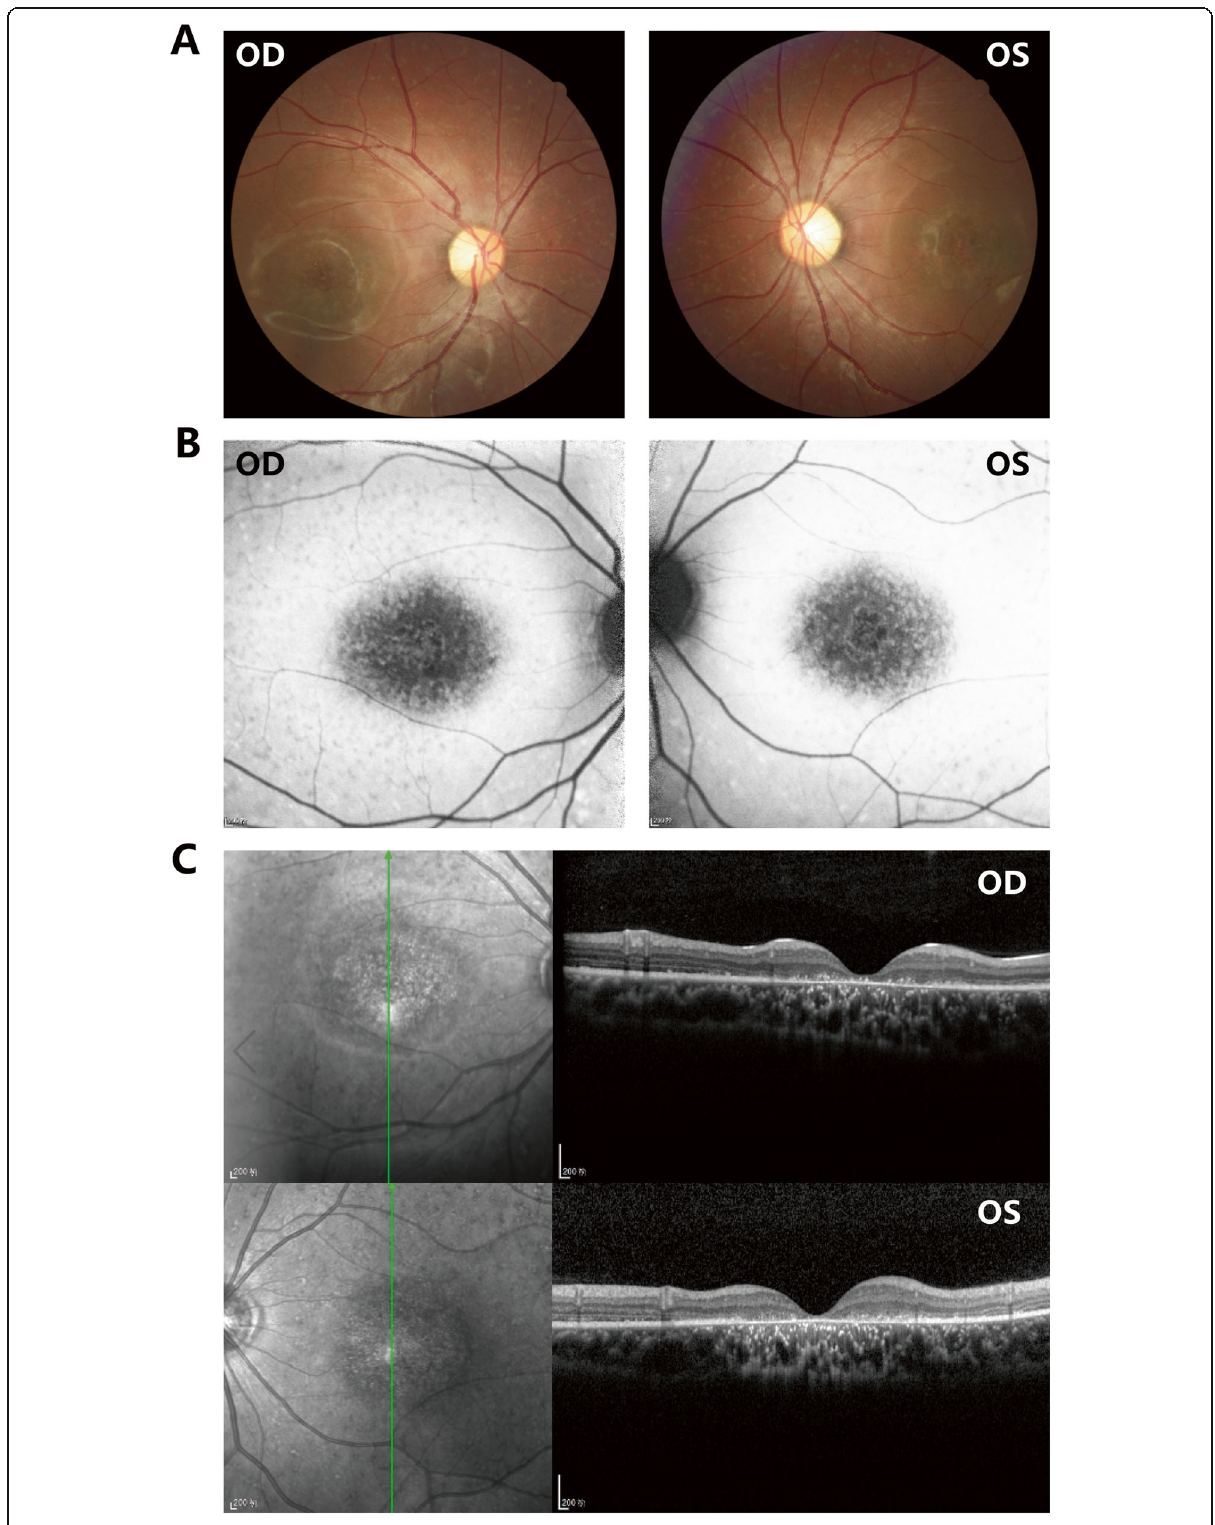
Fig. 2 The representative images of ophthalmologic examination from proband F1:II:2. a Fundus photographs exhibiting macular atrophy and yellow-white spots in the posterior pole. b FAF exhibiting macular hypo-autofluorescence corresponding with atrophy and multiple hyper- fluorescent dots corresponding with subretinal flecks. c OCT exhibiting the significant thinning of retinal outer layers in macular